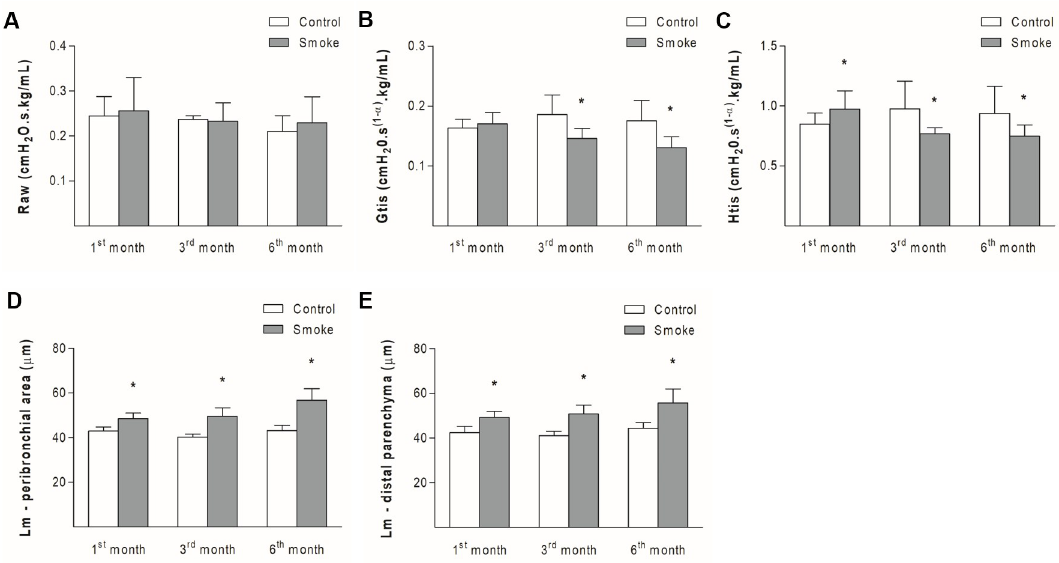
Fig 1. Respiratory mechanics parameters and alveolar enlargement. The values of Raw (A), Gtis (B), Htis (C), Lm of the peribronchial areas (D) and lung distal parenchyma (E) obtained for the Control groups after 1 (n = 10, 10, 10, 7, and 9, respectively), 3 (n = 4, 4, 5, 6, and 5, respectively), and 6 (n = 4, 6, 6, 6, and 7, respectively) months and the Smoke groups after 1 (n = 11, 11, 11, 10, and 11, respectively), 3 (n = 7, 7, 5, 6, and 6, respectively), and 6 (n = 7, 10, 10, 11, and 11, respectively) months are presented as the means ± SDs. (A) No significant difference was detected. (B) Significant differences were observed after 3 ( � P = 0.0242, Mann- Whitney test) and 6 ( � P = 0.0173, Mann-Whitney test) months. (C) Significant differences were found after 1 ( � P = 0.0265, Mann- Whitney test), 3 ( � P = 0.0317, Mann-Whitney test), and 6 ( � P = 0.0339, t-test) months. (D) Significant differences were found after 1 ( � P = 0.0002, Mann-Whitney test), 3 ( � P = 0.0002, t-test), and 6 ( � P = 0.0001, t-test) months. (E) Significant differences were detected after 1 ( � P = 0.0002, Mann-Whitney test), 3 ( � P = 0.0008, t-test), and 6 ( � P = 0.0004, t-test) months. (Fig 1B; 1 st month, P = 0.4597, Mann-Whitney test; 3 rd month, P = 0.0242, Mann-Whitney